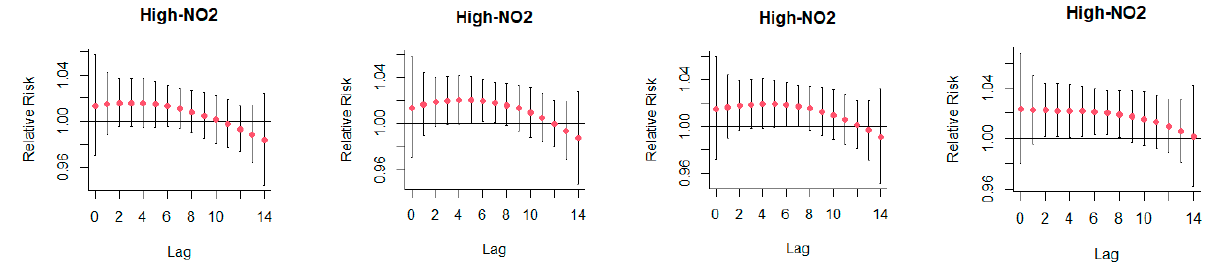
Figure A1. Single-day lag of PM 2.5 , SO 2, and NO 2 , with time-trend degrees of freedom from 8 to 11.